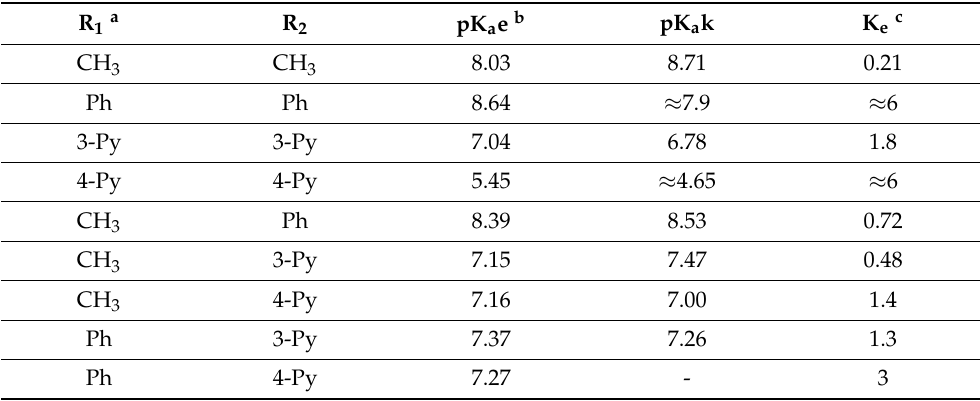
Table 3. pKa values and equilibrium constants for enol to keto-forms. Data from [29] with permission from Canadian Science